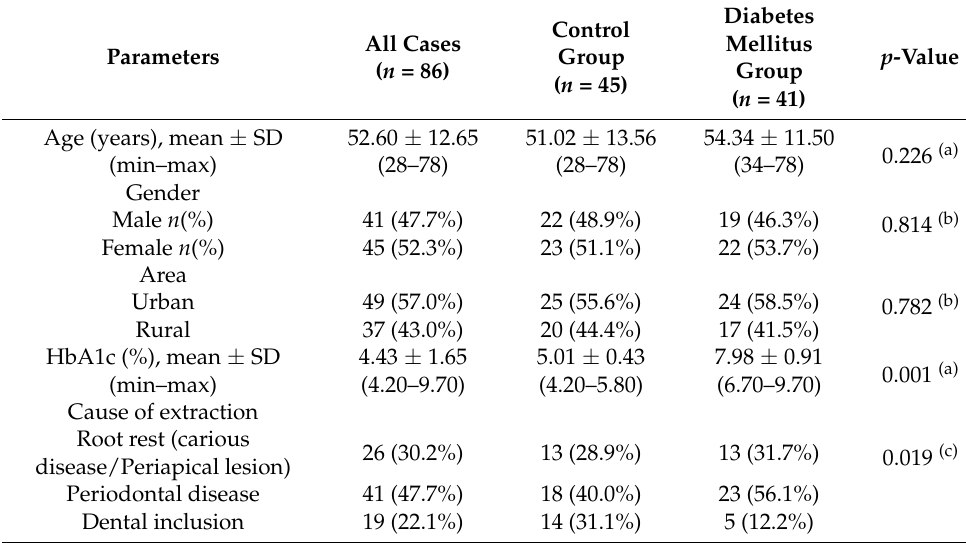
Table 1. Descriptive data for the study